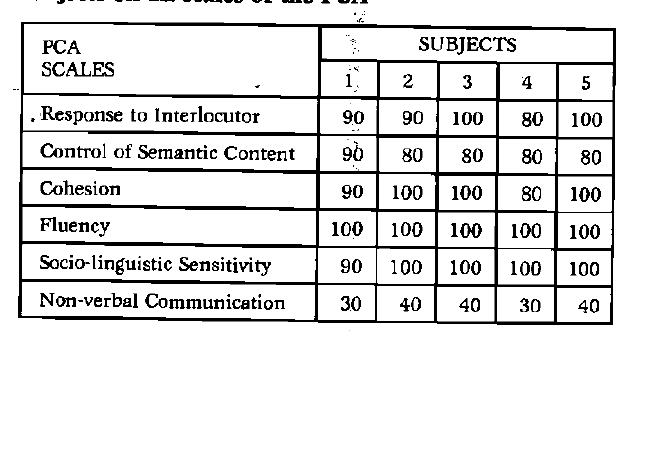
Tahle 2: Percentage of appropriateness obtained by all subjects on all scales of the